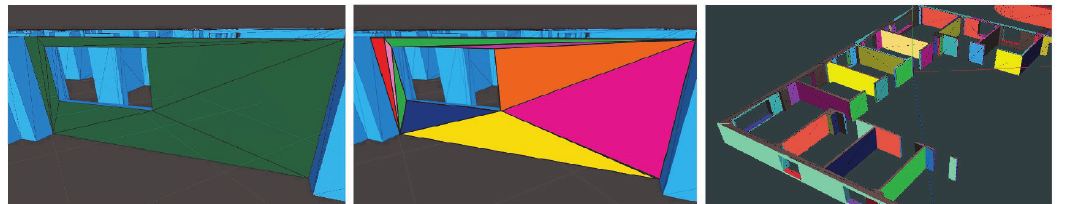
Figure 5. Generation of wall sections by connecting coplanar